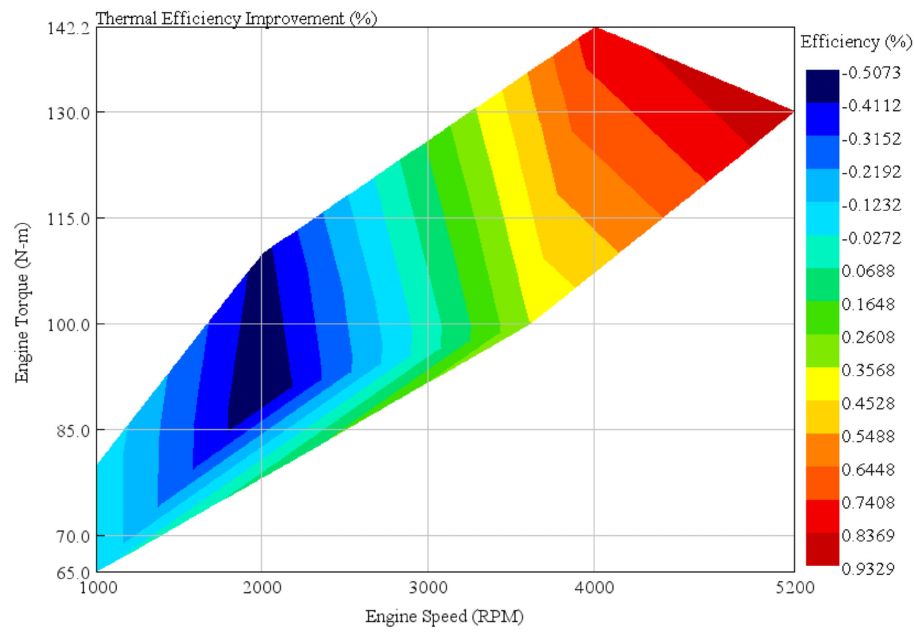
Figure 26. Engine Thermal E ffi ciency Improvement.